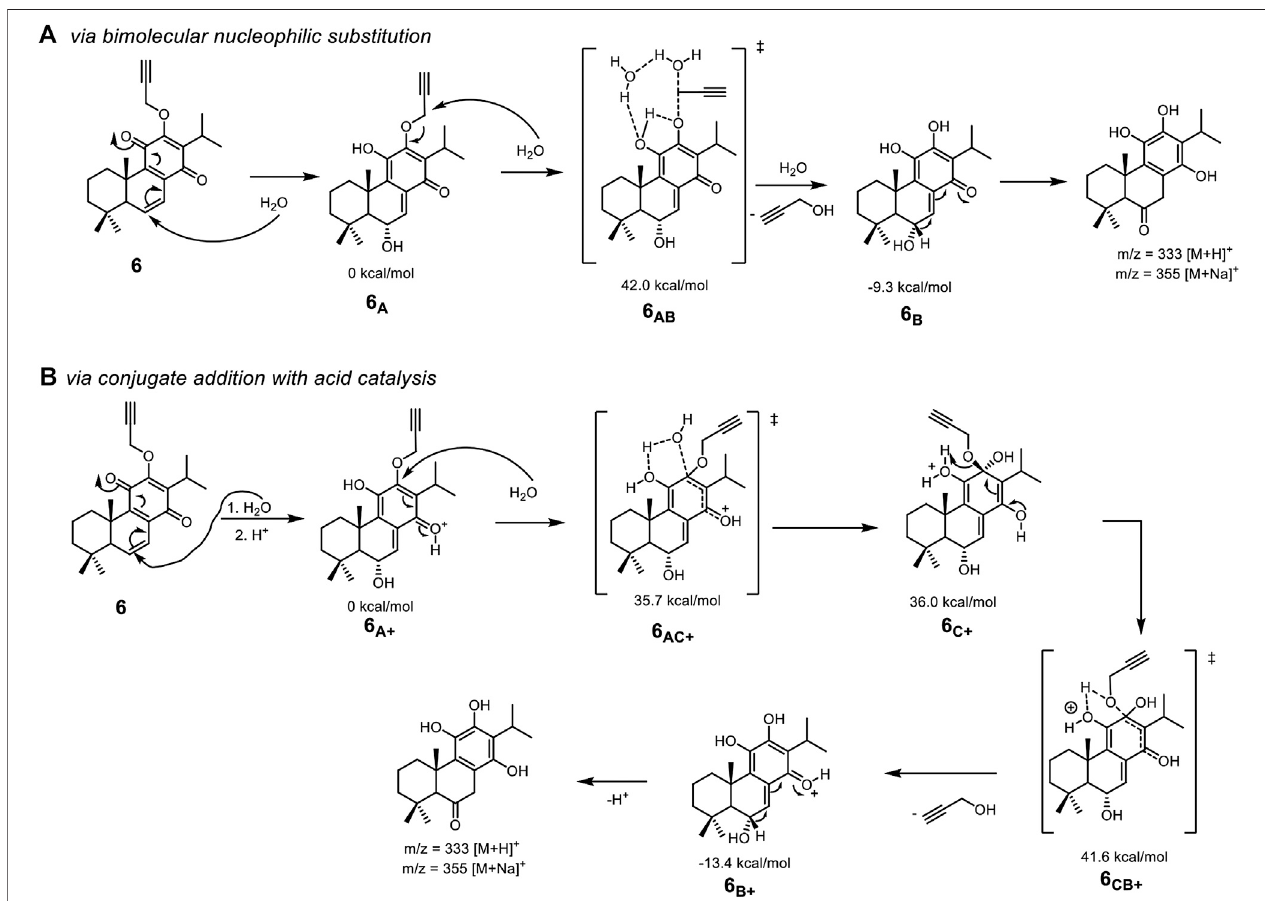
FIGURE 2 | Decomposition mechanism proposal for the unstable derivatives, using derivative 6 as a working model.